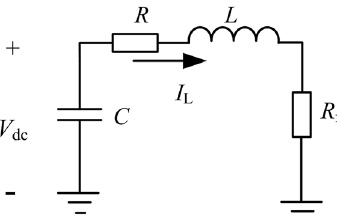
Fig. 6 Equivalent circuit diagram of capacitance discharge in pole-to-ground